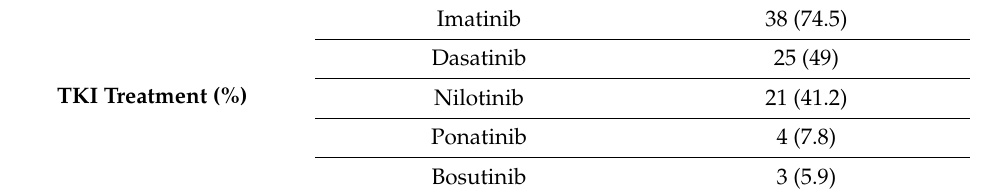
Table 3. TKIs prescribed for the 51 patients included in the study (some patients needed multiple lines of